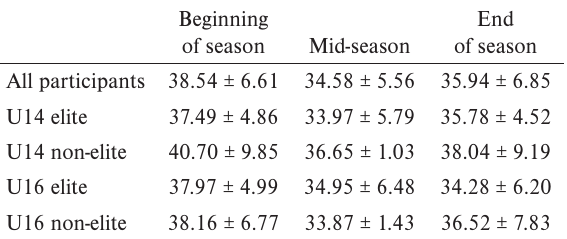
Mean ± SD of relative leg